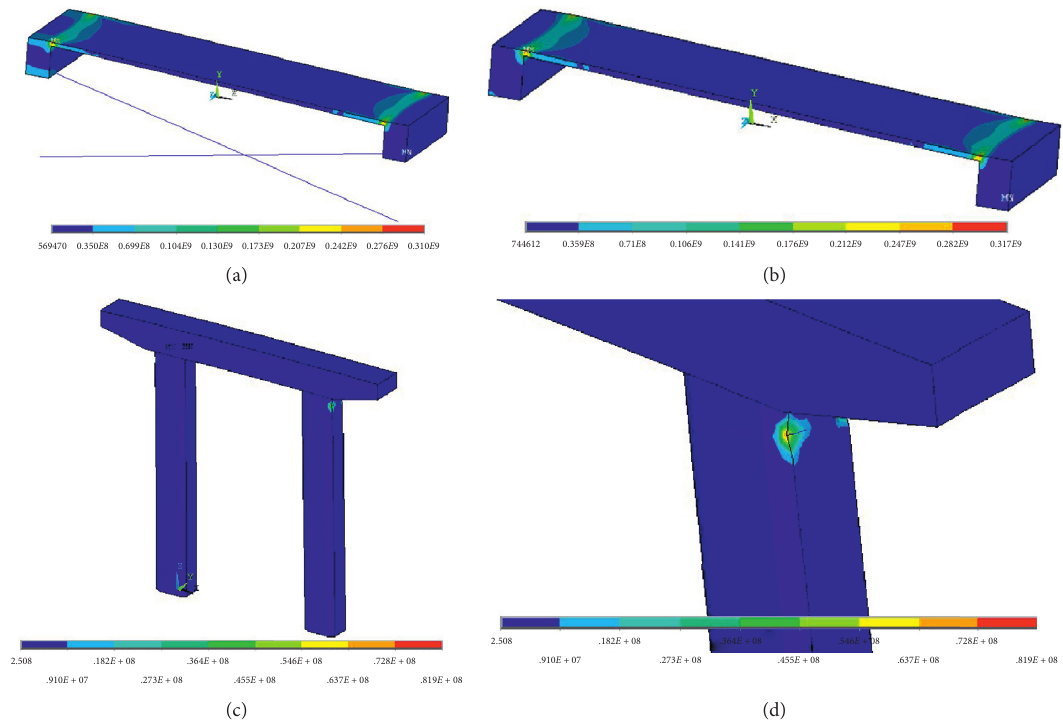
Figure 17: Von Mises equivalent stress distributions on the main girder section and the piers for the emergency rescue cases (unit: Pa). (a) Repair scheme 1 (the main girder section). (b) Repair scheme 2 (the main girder section). (c) Whole view of piers in repair scheme 1. (d) Enlarged view of a pier in repair scheme